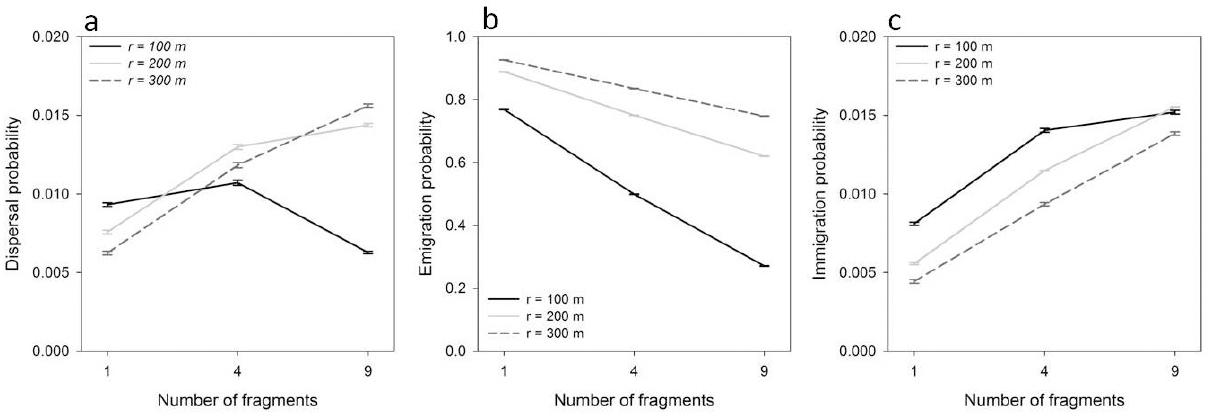
Figure 2. E ff ect of habitat patch structure on (a) dispersal probability between test patches (b) emigration probability from test patches and (c) immigration probability to test patches. Error bars indicate standard